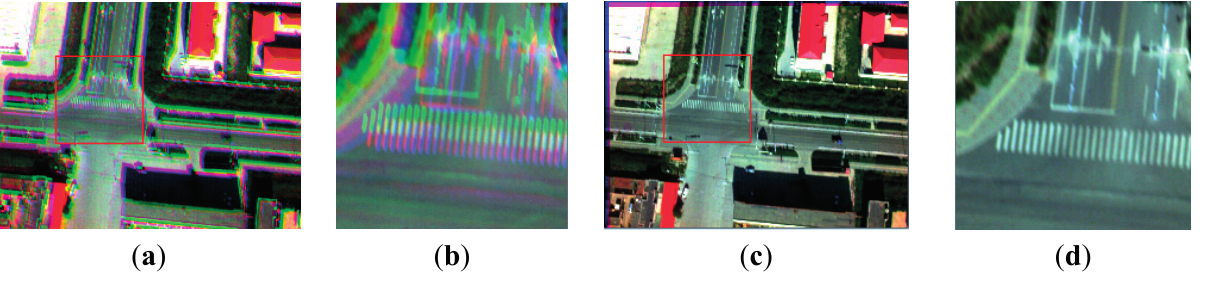
Figure 12. The true-color composite (red, green, blue); ( a ) the unregistered multispectral image; ( b ) the enlarged partial region of ( a ); ( c ) the registered multispectral image; ( d ) the enlarged partial region of ( c